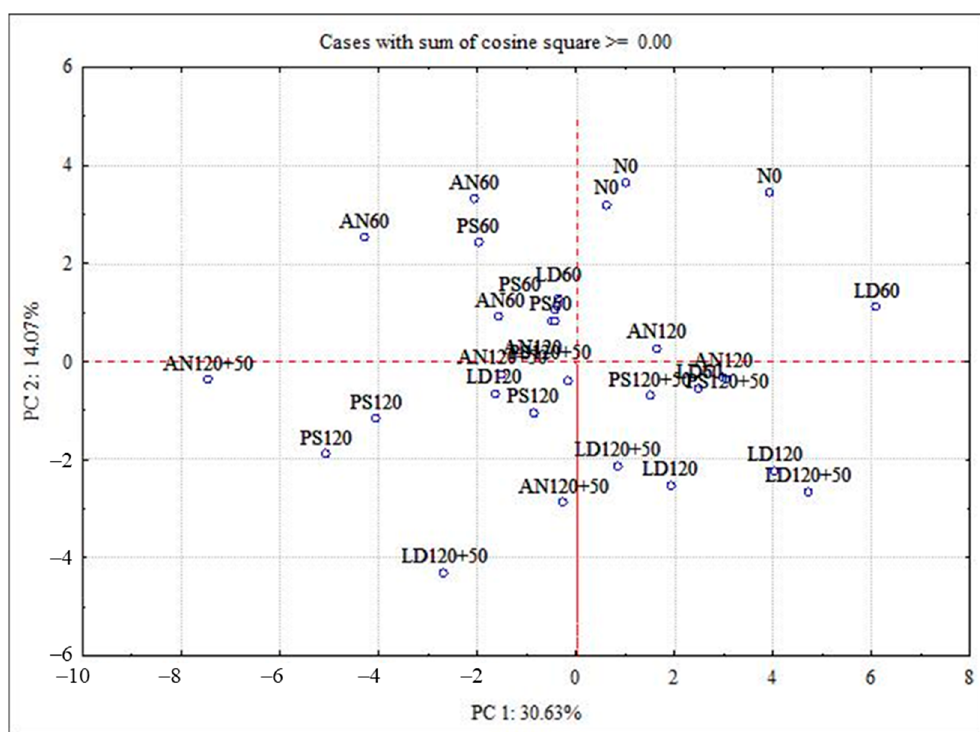
Figure 6. Principal components analysis (PCA) loading plot for PC1 and PC2 scores. Analysis was conducted using data of soil and grain productivity characteristics for waxy winter wheat grown in 2021 using three types of fertilizers (AN, ammonium nitrate; PS, pig slurry; LD, anaerobic liquid digestate) and different nitrogen rates (0, 60, 120, and 120 + 50 kg N·ha − 1 ). The dataset used was of soil collected three times per